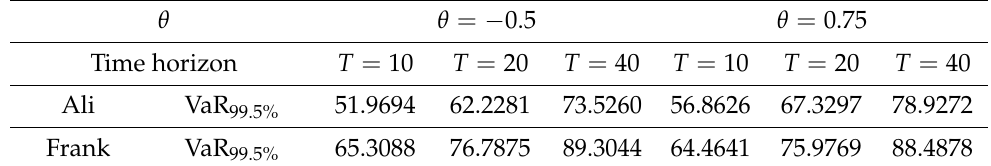
Table 6. Asymptotic value-at-risk for non-homogeneous Poisson risk model with interest rate. α α = 2.5 α = 5 Time horizon T = 10 T = 20 T = 40 T = 10 T =